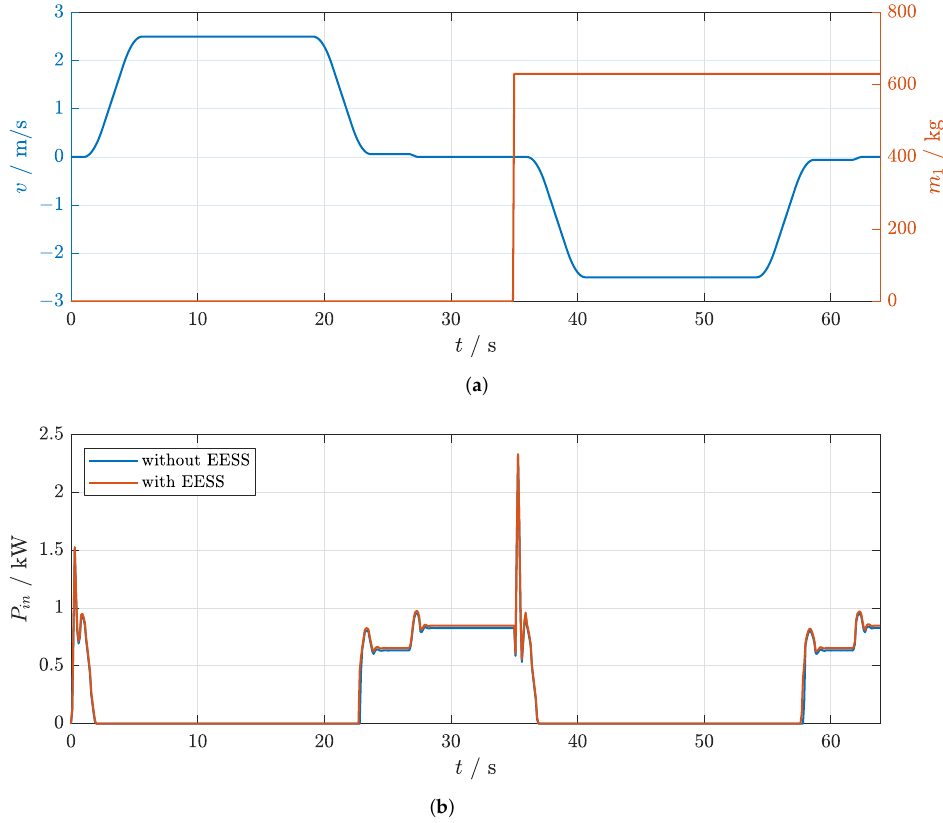
Figure 13. Simulation results for two consecutive regenerative trips. ( a ) Elevator speed setpoint and mass of the load. ( b ) Input